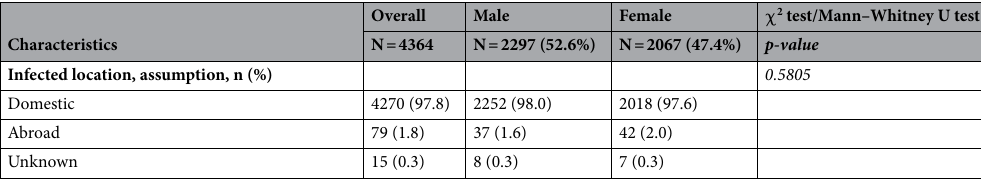
Table 1. Characteristics of 4364 reported TB infections in Nagasaki Prefecture, 2007 to 2018, stratified by sex. APH*: asymptomatic pathogen holder (LTBI + persons under observation). The Chi-square ( χ 2 ) test/Mann– Whitney U test was used to assess differences in reported TB infection according to sex with a p-value less than 0.05 is statistically significant.